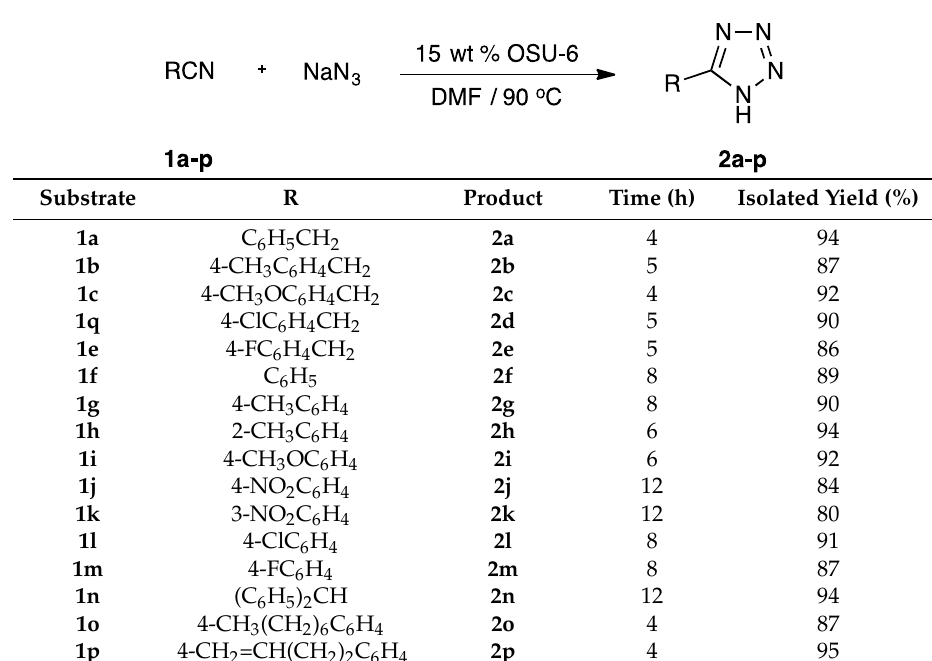
Table 2. Synthesis of